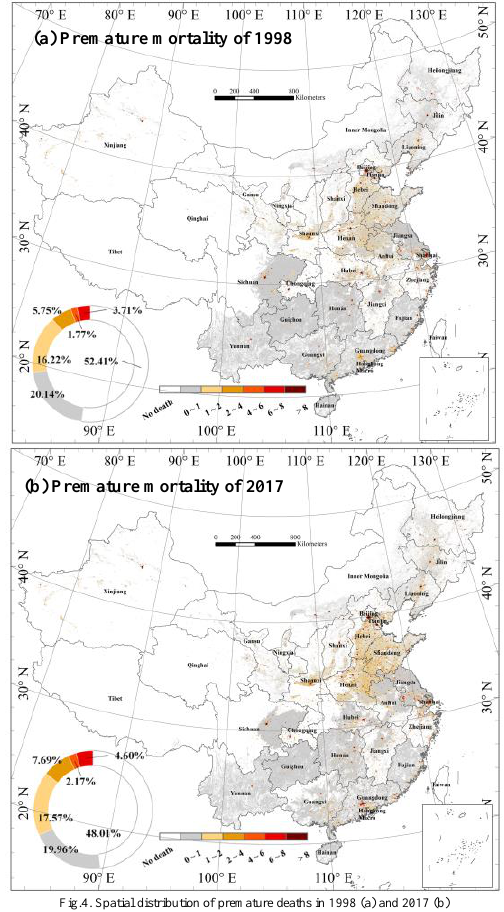
Fig.4. Spatial distribution of premature deaths in 1998 (a) and 2017